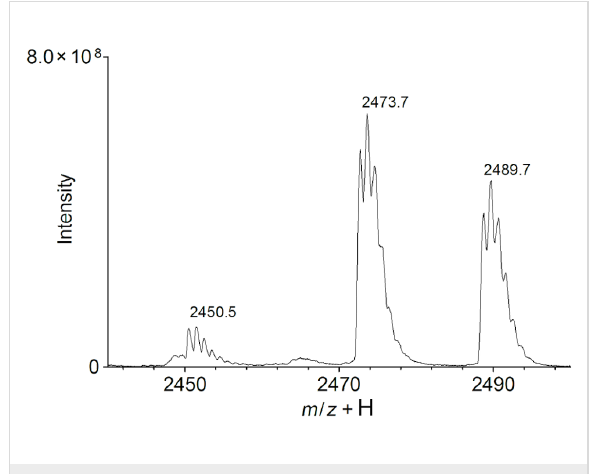
Figure 1: MS spectra (2440–2500 Da) of the purified β -CD dimer.